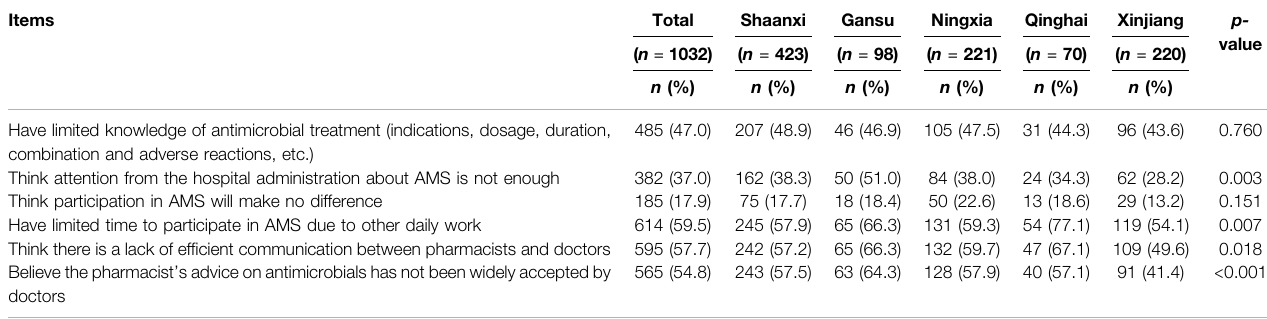
TABLE 6 | Perceived barriers of the pharmacist toward participating in AMS (combined agree or strongly agree response).